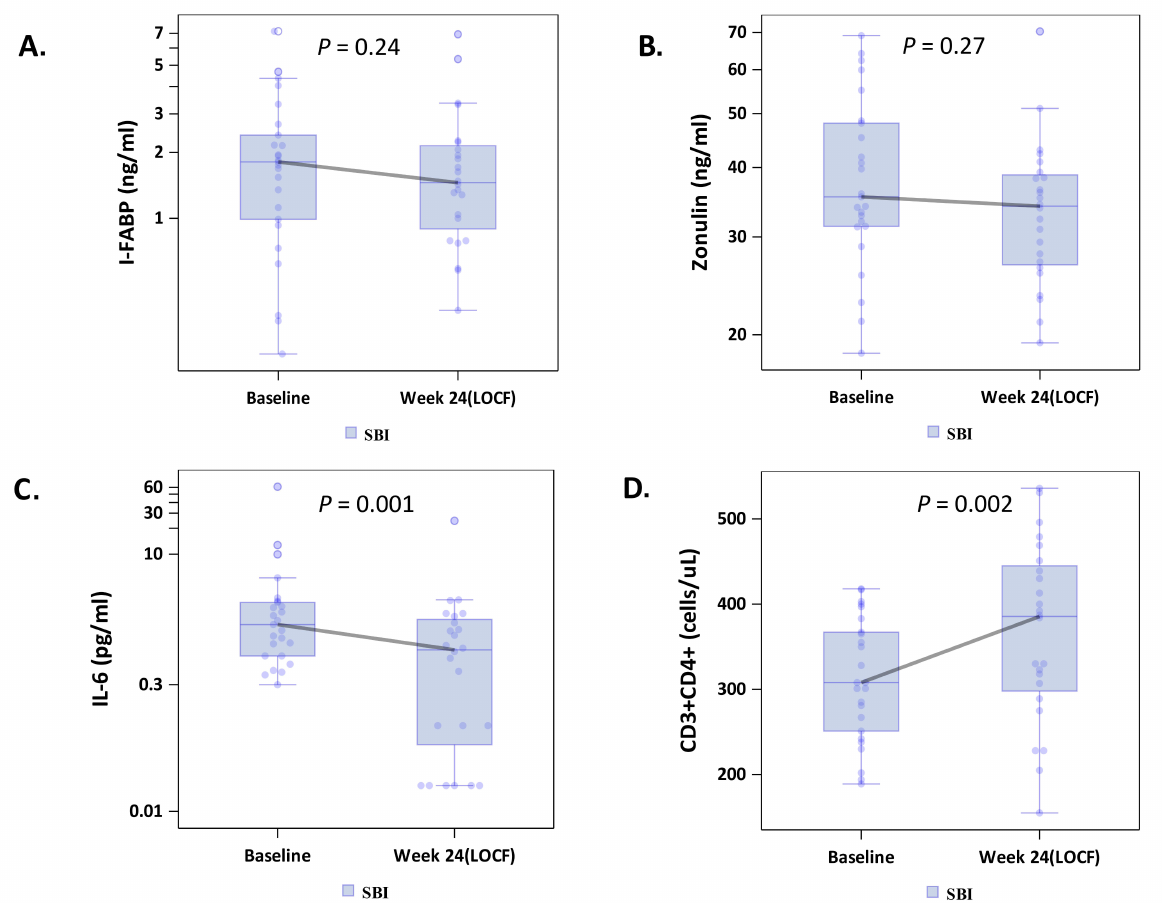
Figure 2. Effects of serum bovine immunoglobulin/protein isolate (SBI) on biomarkers of intestinal per- meability (A-B; intestinal fatty acid binding protein [I-FABP], zonulin), (C) inflammation (IL-6) and (D) CD4+ T-cell counts among participants with the lowest quartile of CD4+ T-cell